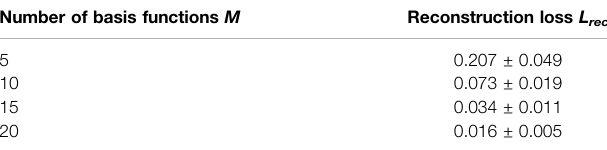
TABLE 1 | Reconstruction loss with respect to number of basis functions in ProMPs.Thereconstructionlossiscomputedusing D KLS ( τ (cid:3) τ 9 ).Hereweshow the mean and standard deviation on the reconstruction loss from three randomly chosen participants, corresponding to 3 · 8 · 4 · 4 (cid:1) 384 sets of trajectories. Each set of trajectories consists of 20 single demonstrations.